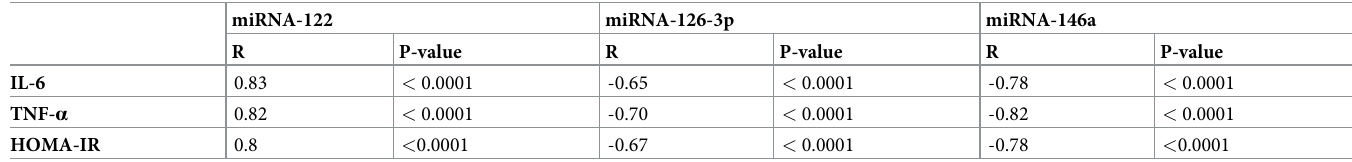
Table 4. The association between miRNA-122, miRNA-126-3p and miRNA-146a expression levels with inflammatory factors and insulin